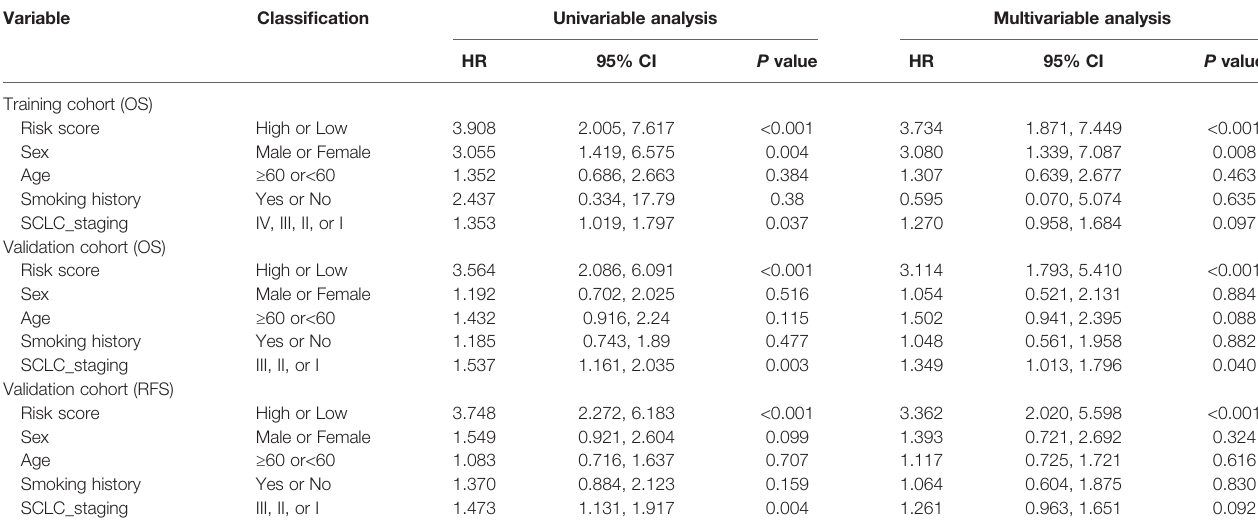
TABLE 2 | Univariate and multivariable Cox regression analysis of TNF family-based signature and outcomes of OS and RFS in training cohort ( N =77) and validation cohort ( N = 137).